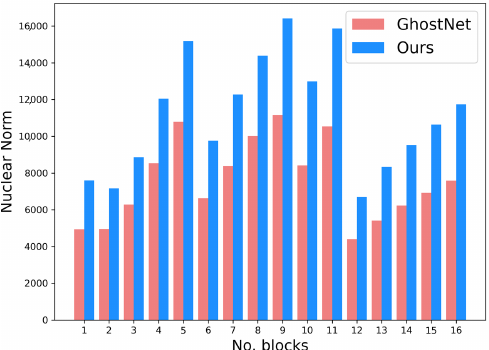
Figure 4. Visualization of the nuclear norm with respect to parameters and FLOPs on CIFAR-10.